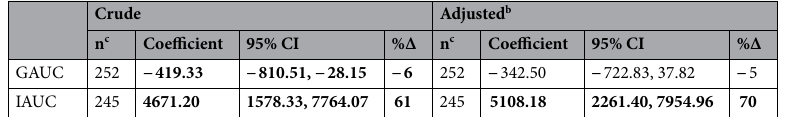
Table 2. Association between WSD and third-trimester GAUC and IAUC (n = 254) a . WSD, western-style diet; CI, confidence interval; GAUC, glucose tolerance test area under the curve; IAUC, insulin area under the curve. a Nineteen pregnancies on control diet were excluded for this table due to their diet history (they were placed on control diet after being exposed to WSD in one or more prior pregnancies). b Adjusting for age and parity. c Sample size differs from 254 due to missing GAUC or IAUC measurements. The bold indicates significantly different values from the reference